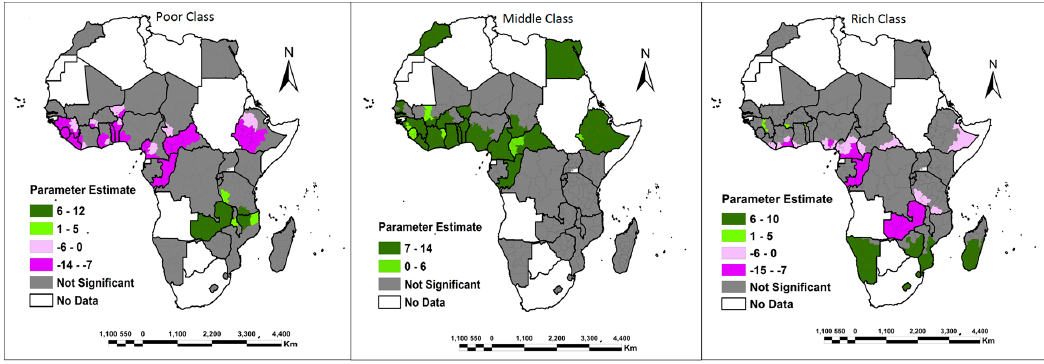
Figure 13. Spatial distribution and significance of wealth class on women’s access to own land.